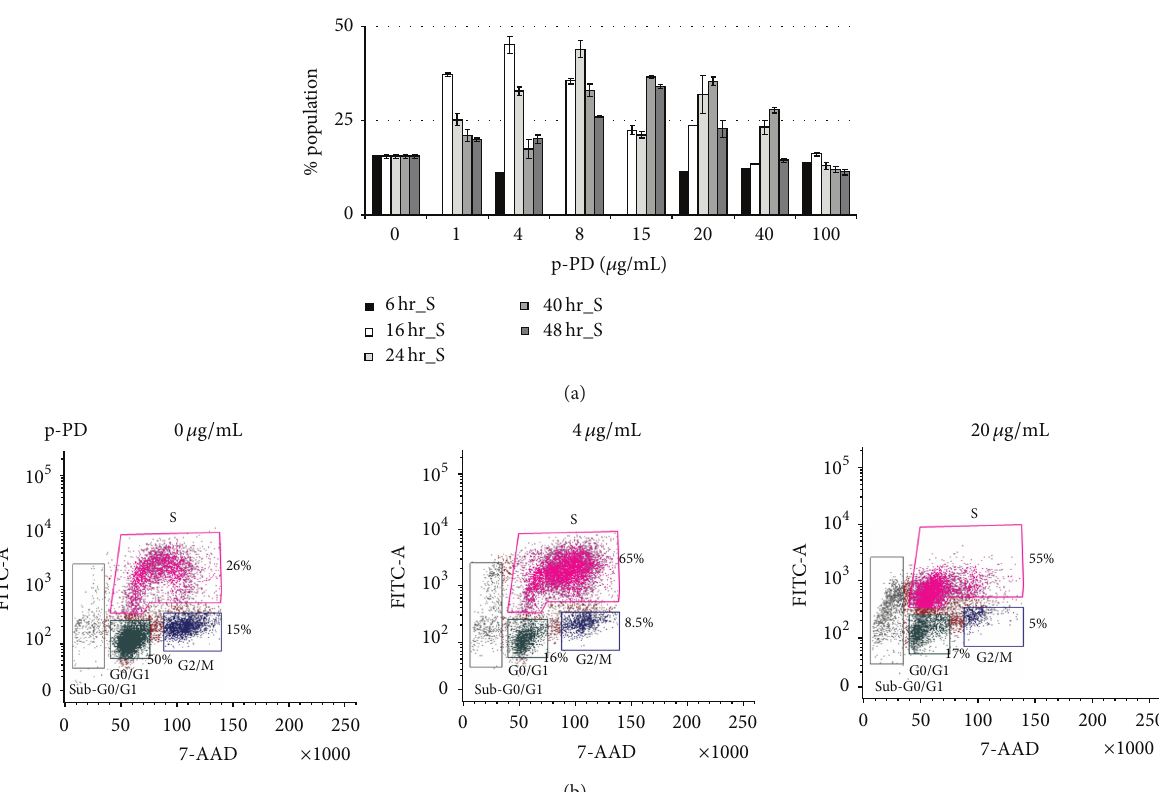
Figure 4: Cell cycle arrest at S phase imposed by p-PD. (a) Cell cycle distribution of A375 cells treated with p-PD as indicated was determined by PI staining using flow cytometry. The number of cells in S phase for each set was determined and plotted against indicated concentration of p-PD. Error bars represent SD; 𝑛 = 3 . (b) Flow cytometric analysis of BrdU incorporation by A375 cells treated with indicated concentrations of p-PD. The BrdU positive cell cultures at the S phase are gated in pink. Respective percent cell numbers are shown next to the gated cell clusters representing cell cycle